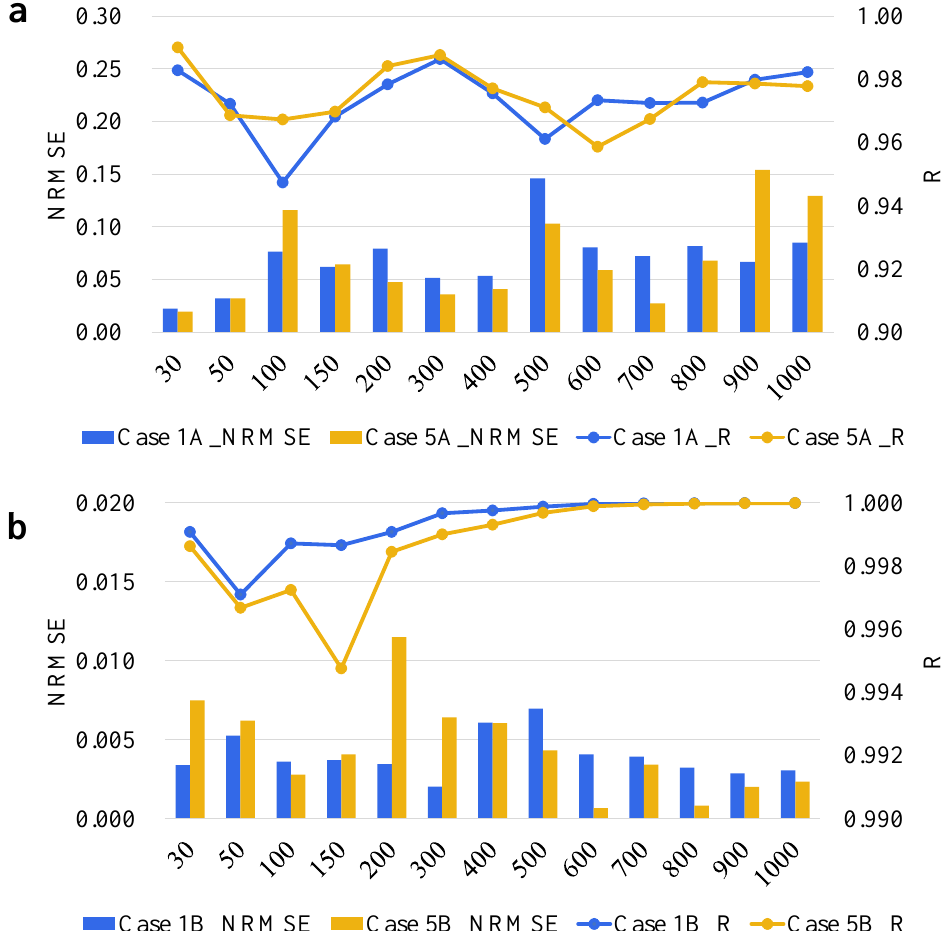
Figure 12. The inversion accuracy of ( a ) ST and ( b ) SS for monthly and daily data at different depths using the ConvLSTM